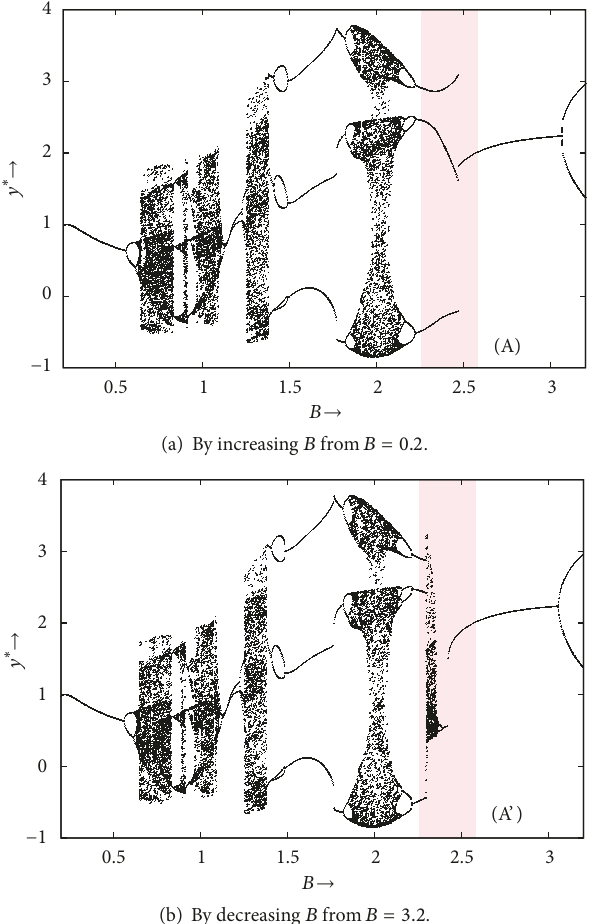
Figure 4: 1-dimensional bifurcation diagram of system (3) with 𝑓(𝑦) = 𝑓 (𝑦) , 𝐵 = 0.5𝜋 , and parameters (20). 𝑦 ∗ corresponds to 1 0 the 𝑦 -coordinate of the Poincar´e